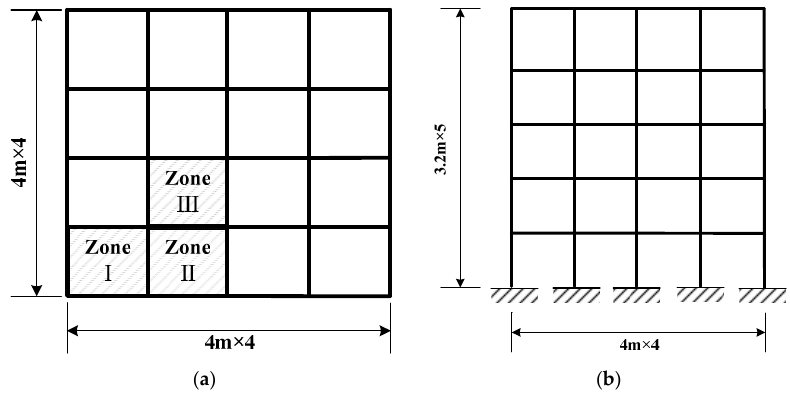
Figure 1. Structure plane layout and vertical layout. ( a ) Structure plane layout and the distribution of the uneven settlement zone. ( b ) Vertical layout of the structure.